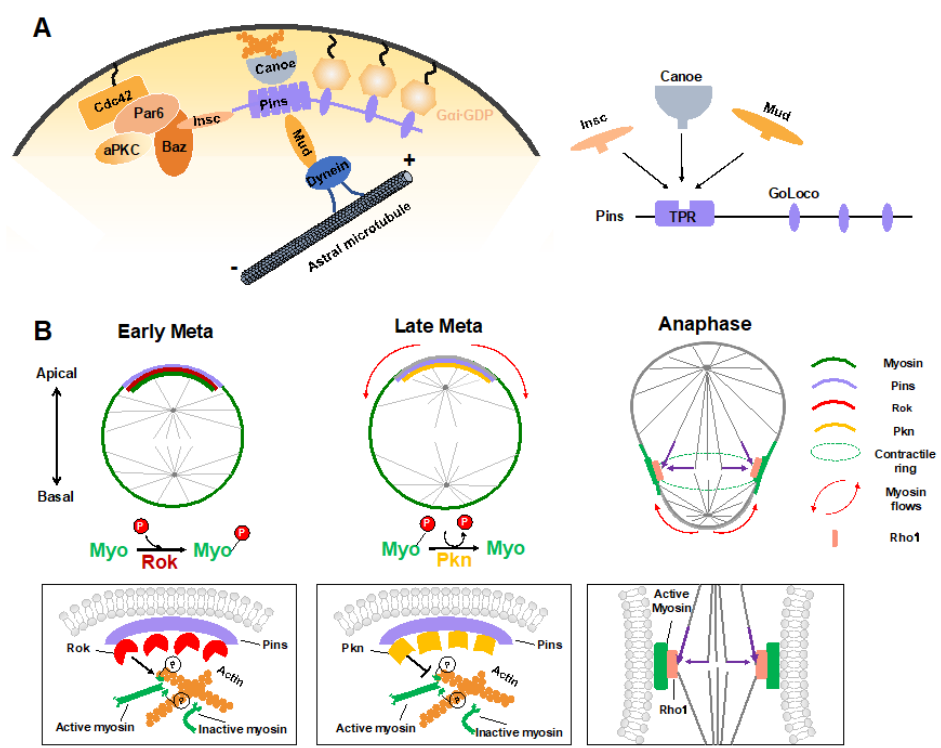
Figure 3. Mechanical forces in regulating ACD of Drosophila NBs. ( A ) Apical polarity cues Pins and Canoe mediate the assembly of force generators of spindle orientation via guiding the cortical attachment of the Mud–Dynein complex. Intriguingly, Insc, Canoe, and Mud competitively bind to Pins, even though they function cooperatively in the polarity-guided spindle orientation process. ( B ) Polarity cues and the mitotic spindle regulate spatiotemporal myosin flows to determine biased cortical expansion and cleavage furrow positioning to generate sibling cell size asymmetry. Rok activates myosin through phosphorylation and mediates its cortical localization before mitosis. Pins recruits Rok apically at early metaphase and thereby enriches active myosin at the apical cortex. Subsequently, Pins recruits Pkn apically at late metaphase, leading to timely apical myosin clearance by inhibiting myosin activity. The relief of myosin contraction at the apical cortex leads to its cortical expansion. At anaphase onset, the spindle-mediated accumulation of active myosin at the lateral membrane (via Rho1) promotes the basal myosin clearance and basal cortical expansion. The lateral membrane site with enriched myosin determines the cleavage furrow